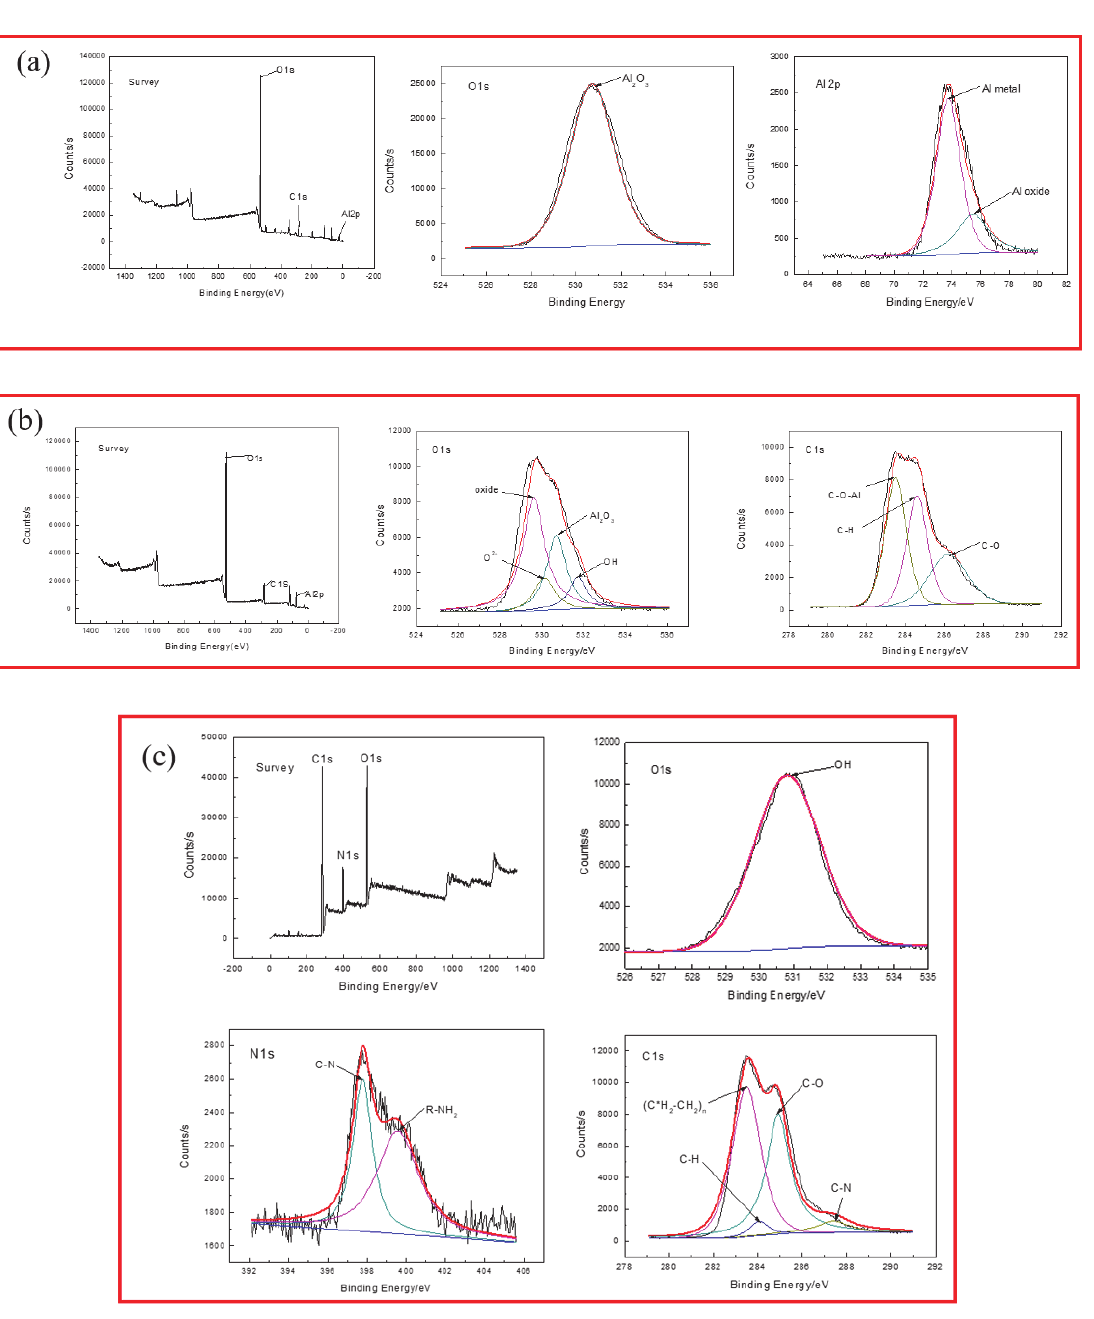
Figure 3. X-ray photoelectron spectroscopy spectrum of different films: ( a ) anodic oxide film, ( b ) sol–gel film, and ( c ) LBL film.